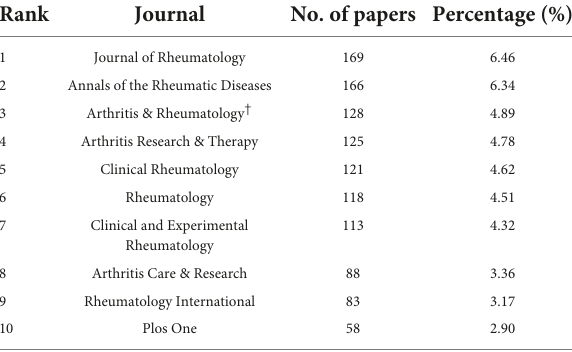
TABLE 2 The top 10 journals contributing to